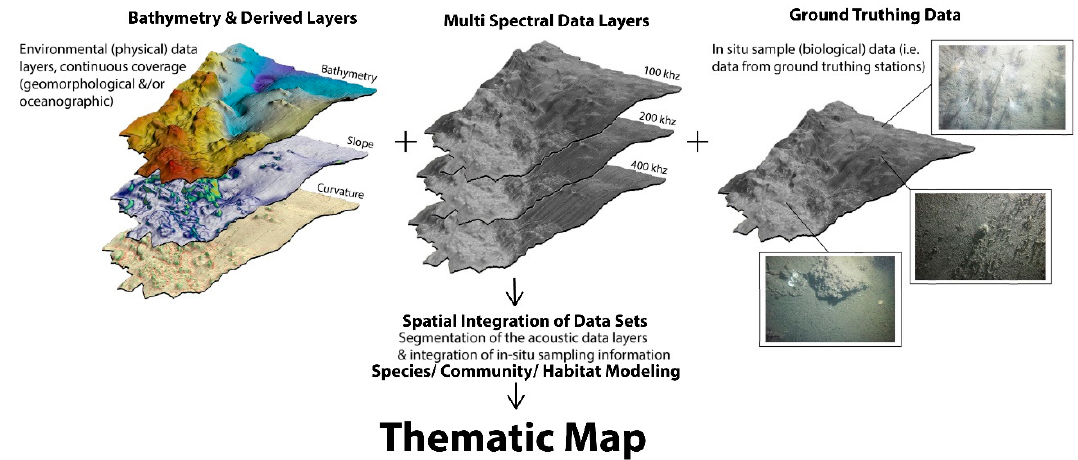
Figure 1. Generalized approach for the production of benthic habitat maps, illustrating typical data sets used for this type of application. The multispectral backscatter layers (i.e., multi-frequency) afforded by the R2Sonic system offer potential advantages over conventional, monochromatic (i.e., single-frequency) systems for improved seafloor characterization .